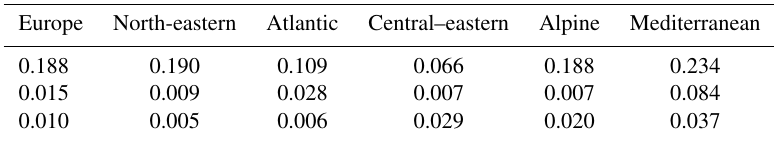
Table A6. R 2 of regional regression models of MAF with catchment area in a double-logarithmic relationship Eq. (5) and analogous equations for CV, and a semi-logarithmic relationship for CS, i.e. CS = log Aβ CS .